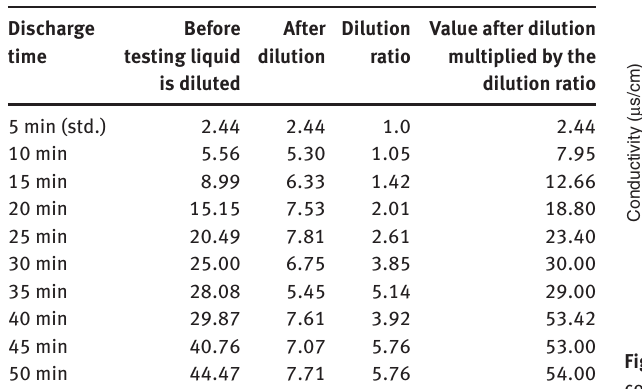
Figure 8: Comparison of electrical conductivity at different